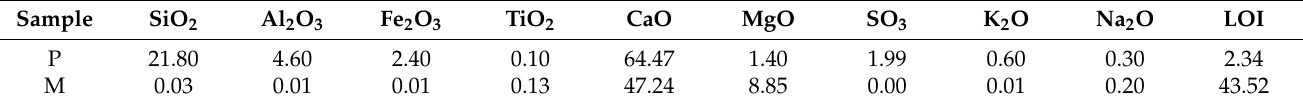
Table 2. Chemical compositions of the raw materials